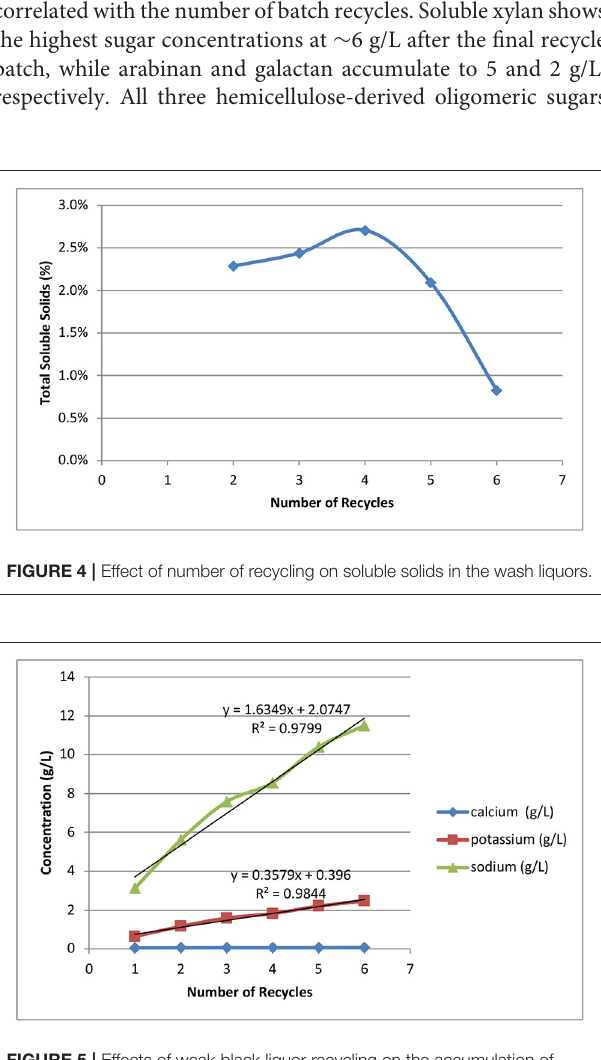
FIGURE 5 | Effects of weak black liquor recycling on the accumulation of sodium, potassium, and calcium in the recycle weak black liquors.